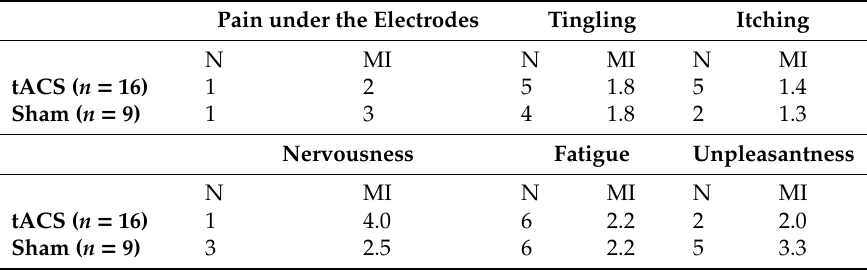
Table 2. Adverse effects of tACS reported after stimulation. N: number of patients; MI = mean intensity (1 = very mild and 5 = extremely strong intensity).